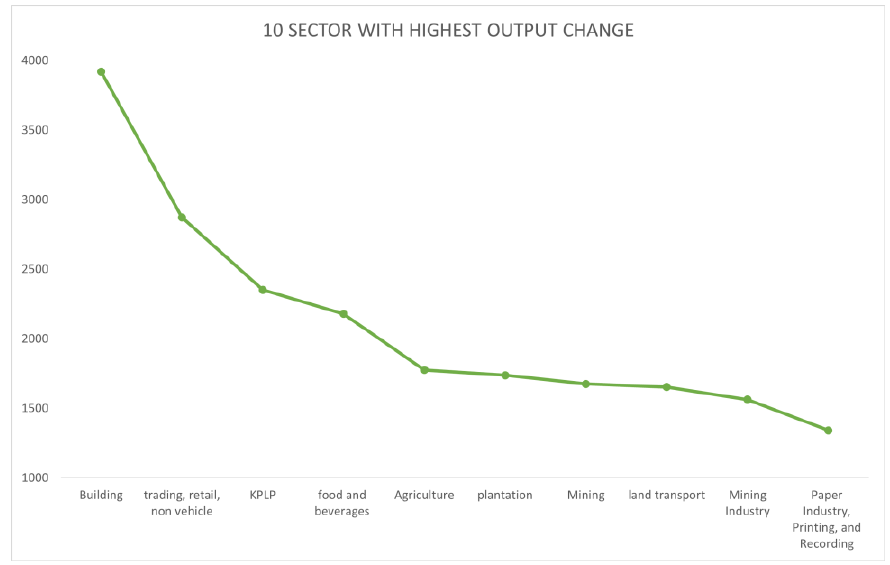
Figure 1. Sectors Affected by the Implementation of Maritime Security Policy in 2019 (Source: [16]).